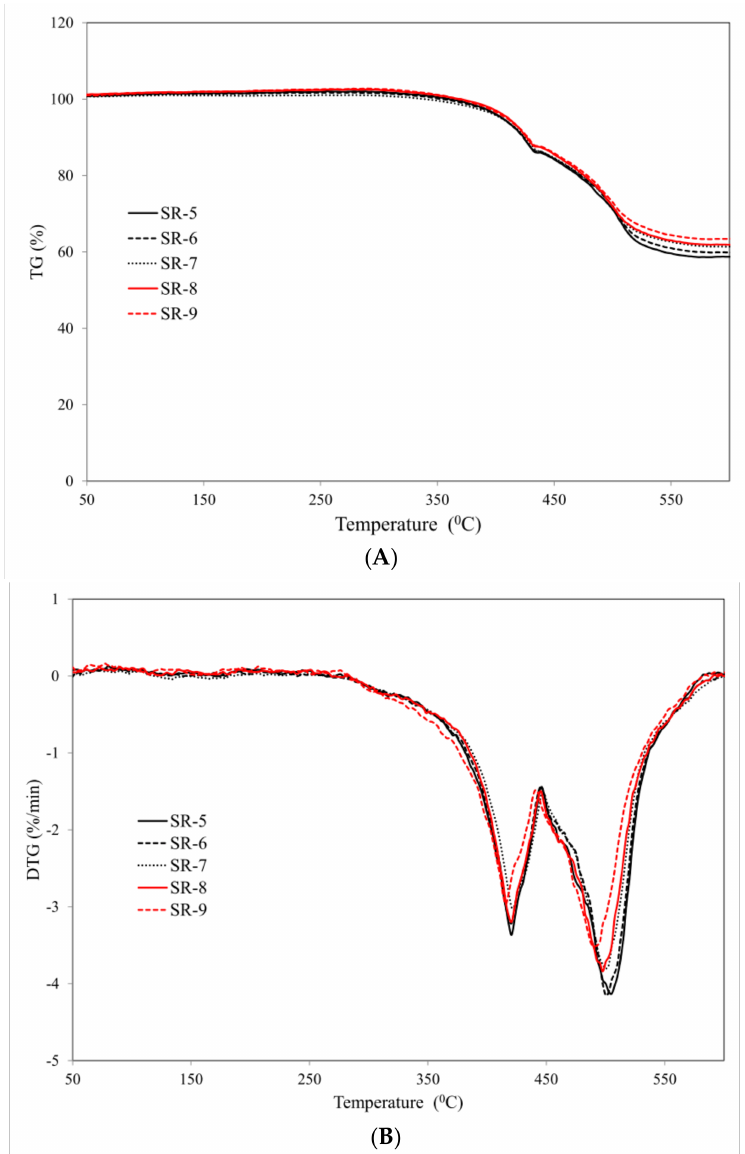
Figure 5. Curves: ( A ) TG ( B ) DTG of the studied ceramizable